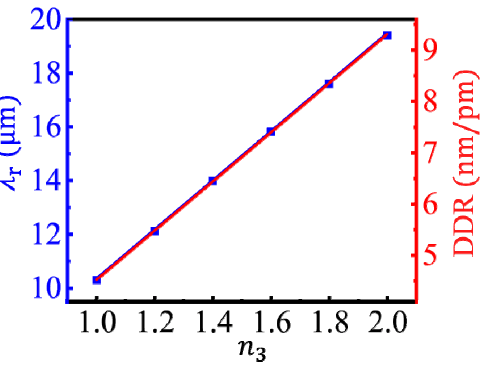
Figure 6. Dependences of the LSPR wavelength (blue line) and the DDR (red line), respectively, on the RI of the dielectric spacer under μ c = 0.5 eV, L = 40 nm, and d = 1.0 nm. Di ff erent from coupled nanostructures made of noble metals, the LSPR wavelength of the CGS can be controlled by tuning the chemical potential of graphene via the gate voltage. The relationship between the chemical potential, µ c , and the voltage, V , can be written as µ c = sgn ( n ) hv F